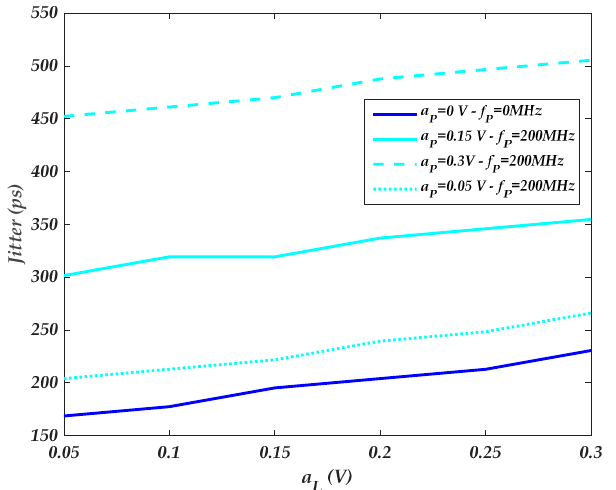
Figure 13. Last-stage parametric plot of the IO buffer amplitude-dependent jitter TF as the last-stage amplitude is swept for different V dd ( t ) supply